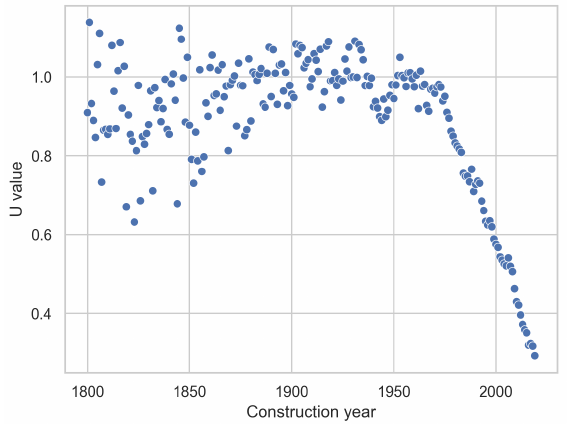
Figure 2. Evolution of the average heat transfer coefficient in relation to the year of construction of